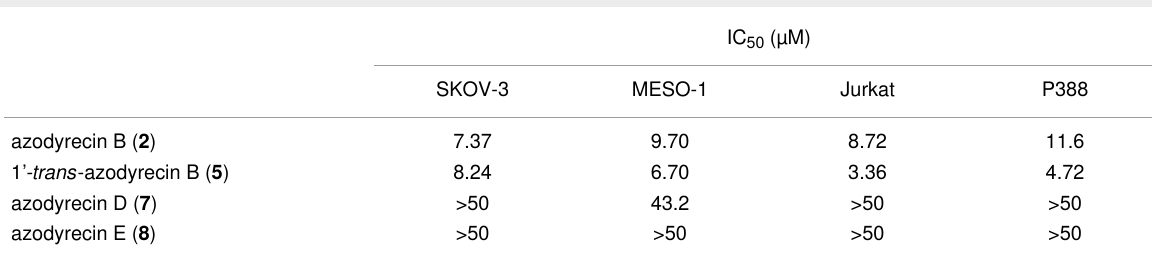
Table 2: Cytotoxicities of compound 2 , 5 , 7 , and 8